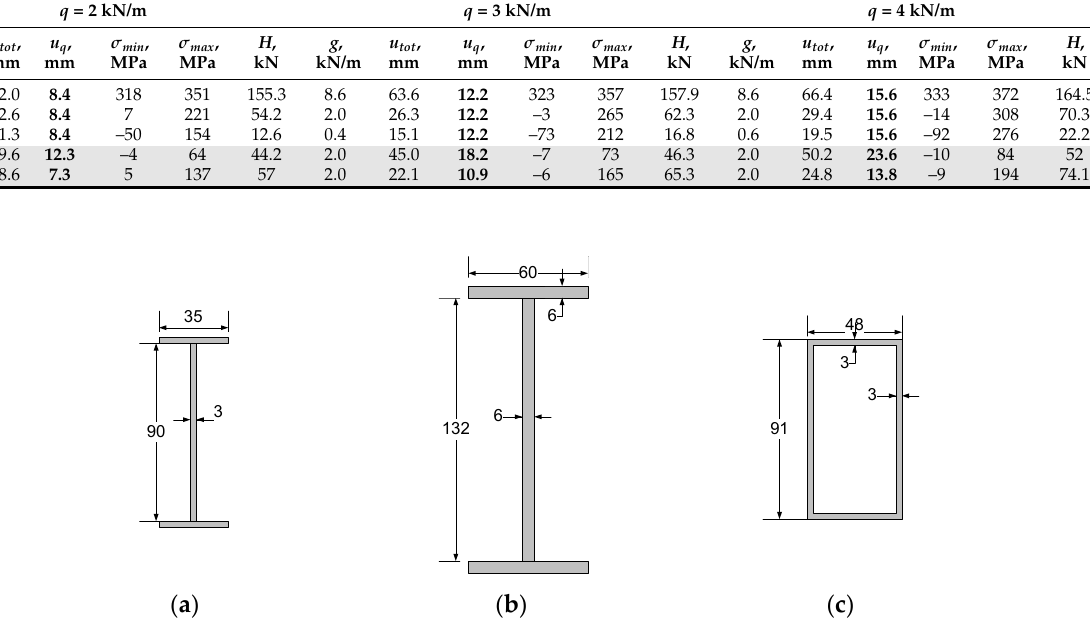
Table 3. Design results of alternative bridge models: vertical displacement components, extremum stresses, and thrust force. Bridge Model